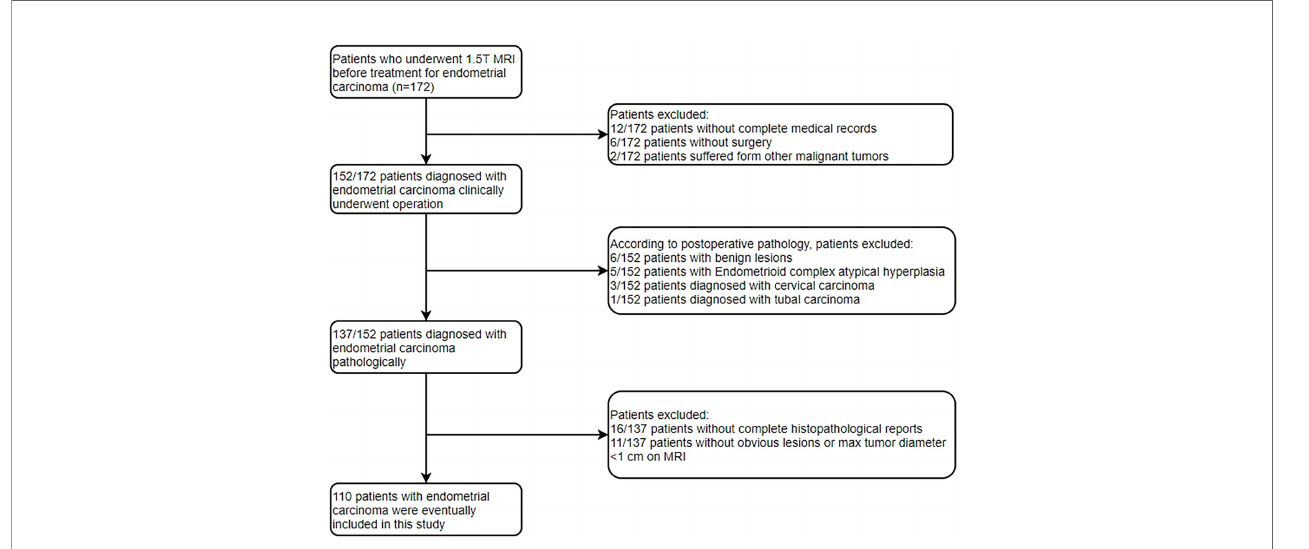
FIGURE 1 | Flowchart shows selection of studying population and exclusion